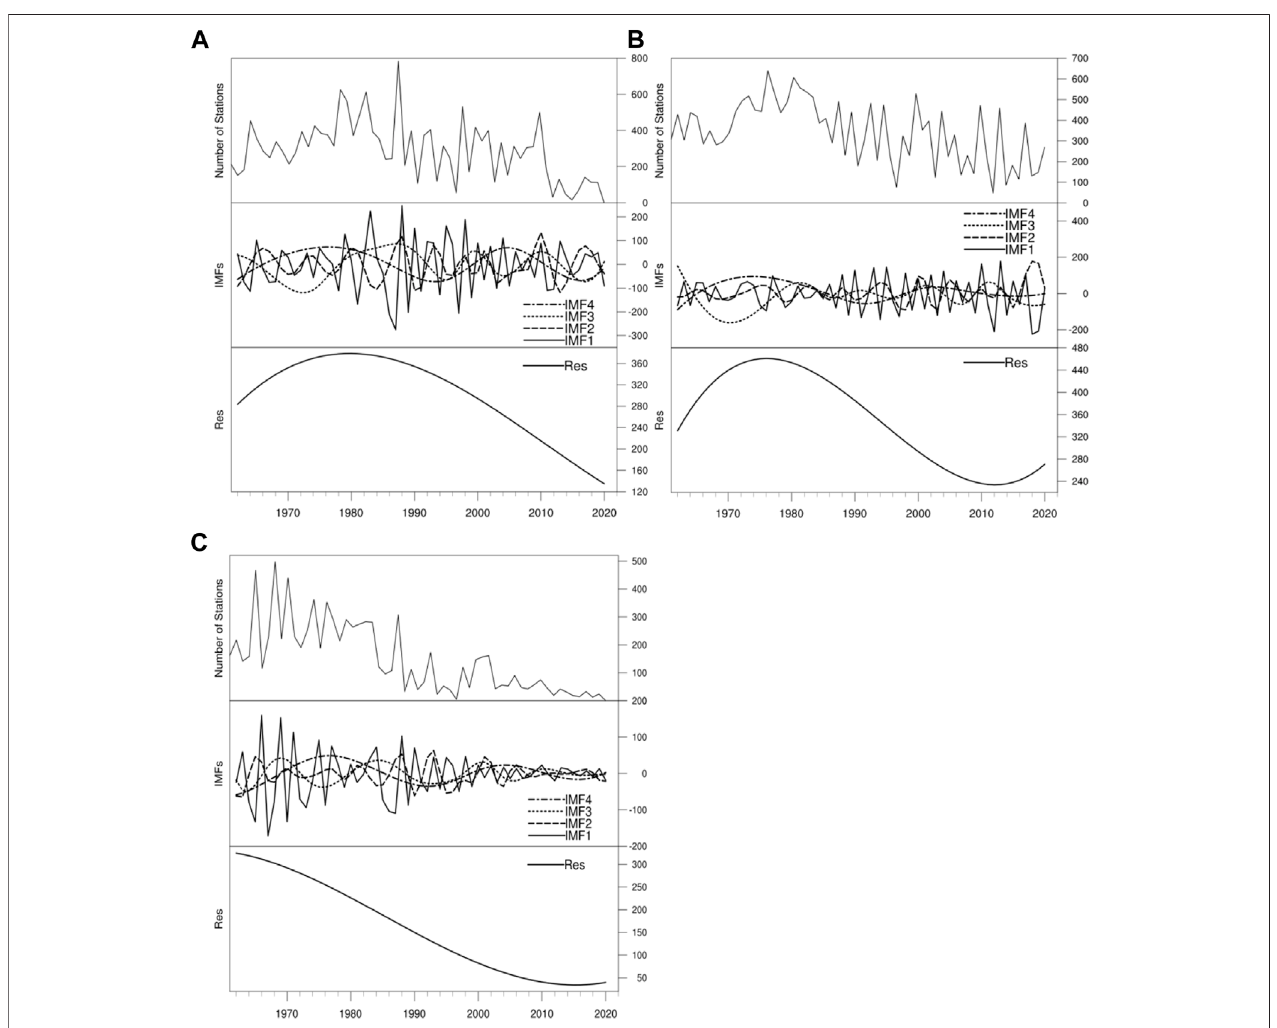
FIGURE12| Annual maximumnumber ofaffectedstations (top)and their EEMDresults (bottom) forthe (A) suspended dust, (B) blowing sand,and (C) sand-dust storm processes.